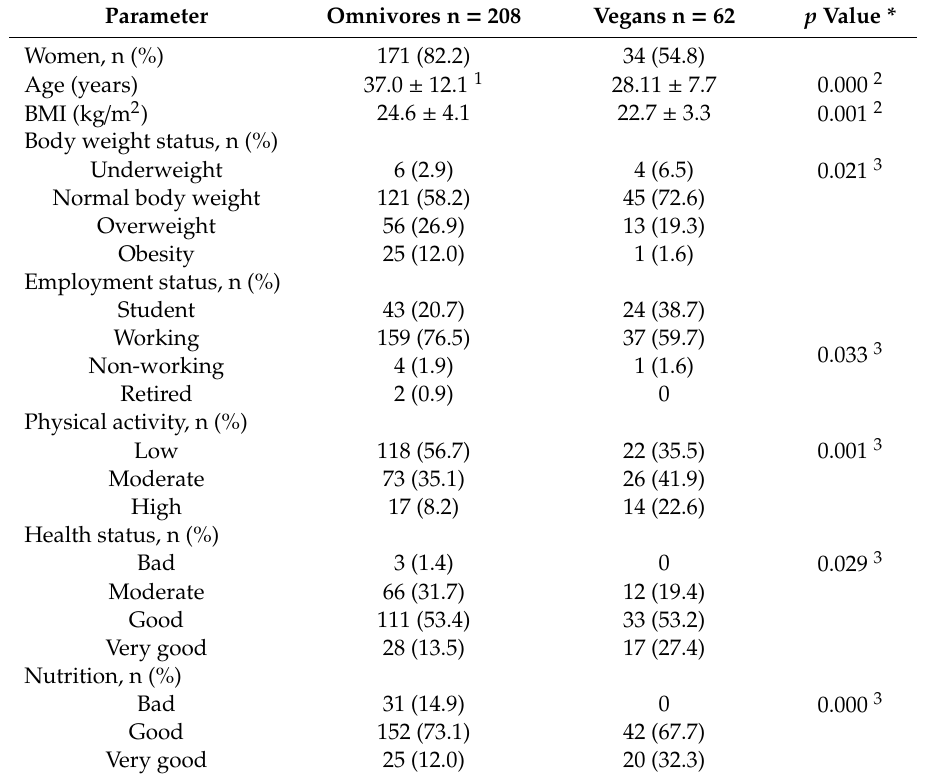
Table 1. Characteristics of the study